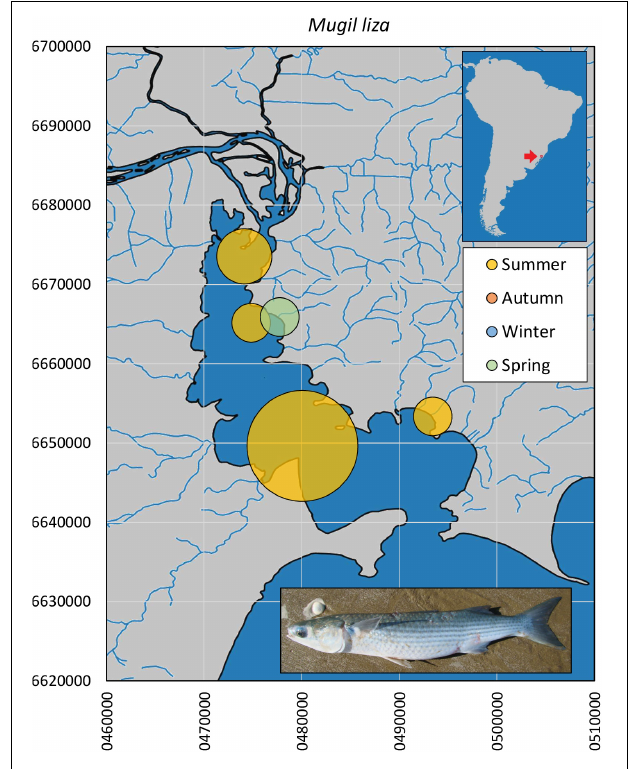
FIGURE 9 | Spatial and seasonal relative abundance of M. liza in Guaíba Lake, southern Brazil. Bubble area proportional to number of captures per site (13 individuals). Fish photograph from Timm, C.D. available at Fishbase.com. Vector map background from FEPAM open database (http://www.fepam.rs.gov.br/biblioteca/geo/bases_geo.asp). 22J UTM